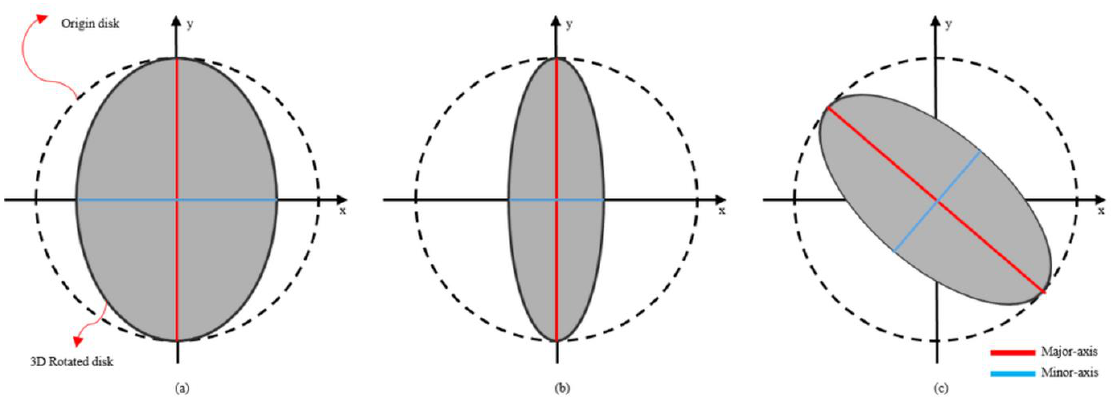
Figure 4. Projected result as an ellipse onto the camera after a disk has rotated each axis. ( a ) The shape of the projected disk when the rotation of the y-axis occurs. ( b ) The shape of the projected disk when the rotation of the y-axis different magnitude from ( a ) occurs. ( c ) The shape of the projected disk when the rotation of the x-, y-, and z-axis are randomly.